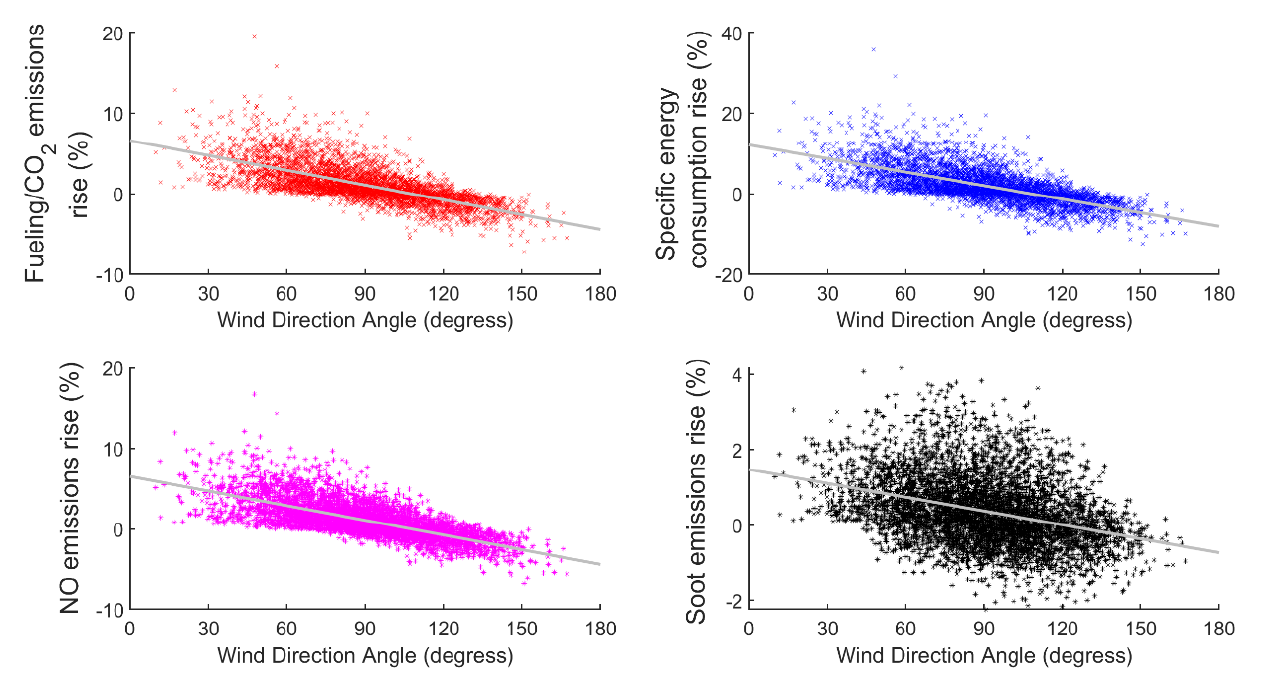
Figure 11. Percentage increase in fuel/energy consumption and emissions vs. mean wind direction for the extra-high phase of the WLTC.